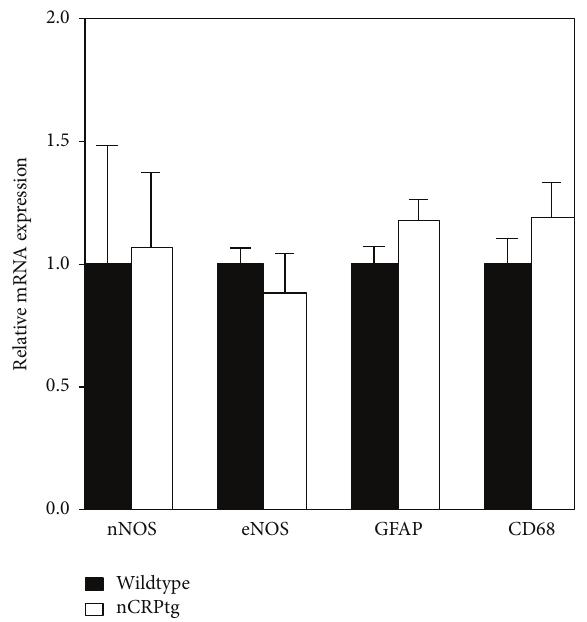
Figure 4: CNS-expressed human CRP does not upregulate the expression of inflammatory biomarkers in the CNS. qRT-PCR of mRNA isolated from the brains of wildtype and nCRPtg mice, 𝑛 = 3 per genotype. Human CRP expression in nCRPtg brains does not influence the expression of endothelial or neuronal nitric oxide synthases (eNOS and nNOS, resp.), GFAP, or CD68. Inducible nitric oxide synthase (iNOS) was not detected in either genotype. Expression of each gene is normalized to expression in wildtype mice.